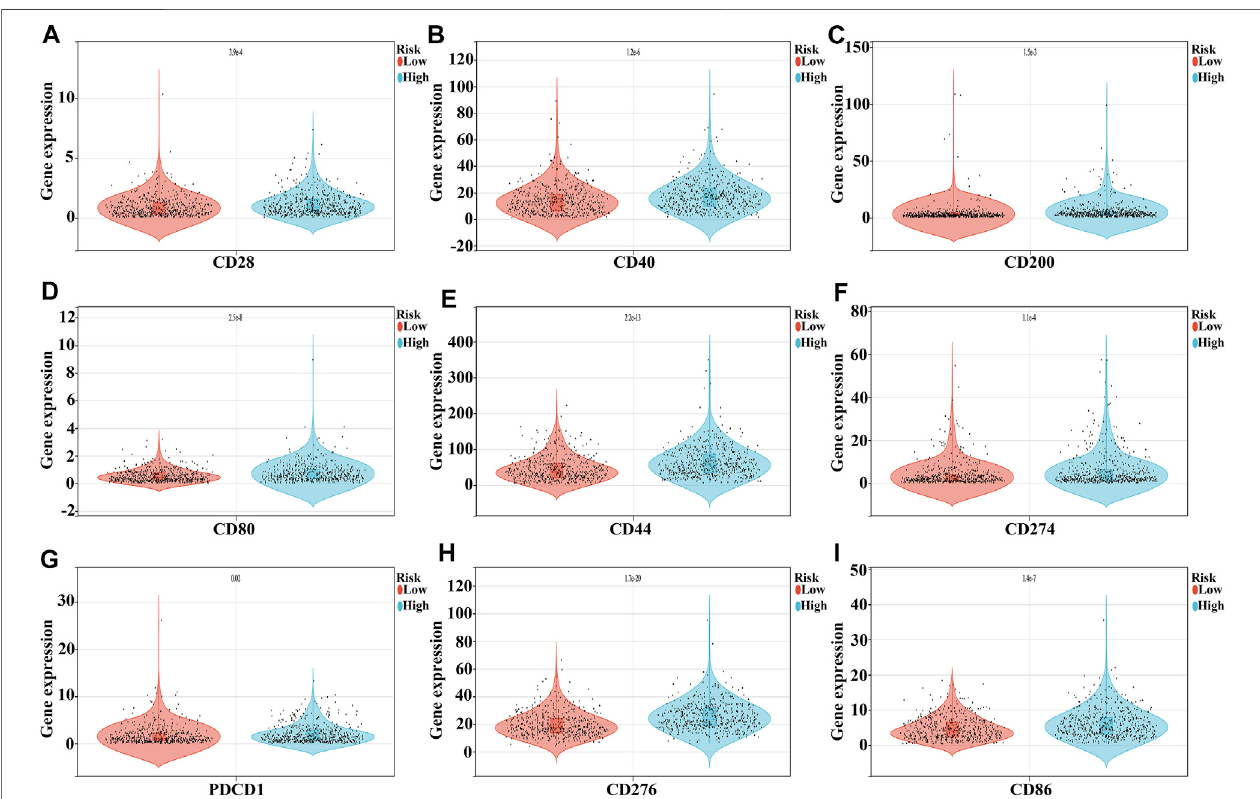
FIGURE 9 | Expression levels of NSCLC immune cell markers in the high- and low-risk groups. (A) CD28; (B) CD40; (C) CD200; (D) CD80; (E) CD44; (F) CD274; (G) PDCD1; (H) CD276; (I) CD86.